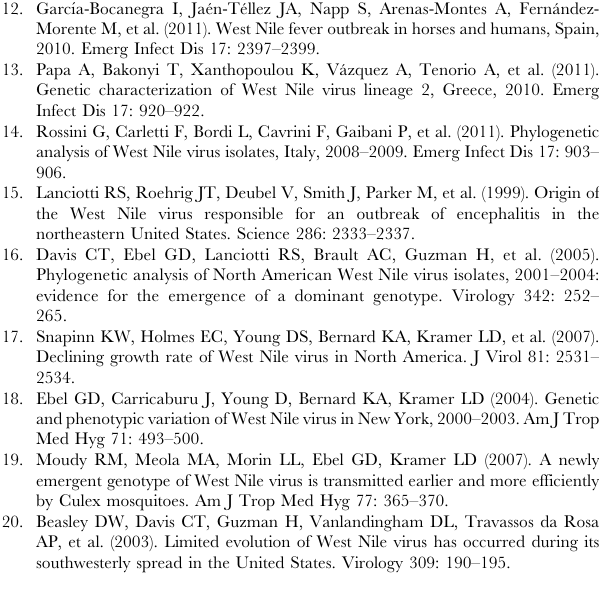
is color-coded according to the insert at the bottom of the figure. Taxon names at the tip of the branches correspond to GenBank accession codes. Figure S2 Consensus maximum-likelihood tree of WNV ORF, from the US (1999–2011), by place of collection (US region) (n =366). Strain IS-98 STD is used as outgroup to root the tree. US regions are color-coded in the branches of the tree as: Northeast (CT, NJ, NY); green, South (FL, GA, LA, MD, MS, TX); orange; Midwest (IL, MI, NE, ND, SD, WI); blue, and West (AZ, CA, CO, ID, NV, UT); red. Strains collected outside the US (Mexico and Israel) are shown in black. Taxon names at the tip of the branches correspond to GenBank accession codes. Figure S3 Consensus maximum-likelihood tree of WNV ORF, from the US (1999–2011), by host (n= 366). Strain IS-98 STD is used as outgroup to root the tree. Host-origin is color-coded in the branches of the tree as: mammals other than humans (black), human (red), avian (blue) and mosquito (green). Taxon names at the tip of the branches correspond to GenBank accession codes. Figure S4 Maximum clade credibility tree derived from the Bayesian analysis of the ORF of WNV strains infecting humans in the US, 1999–2011. WNV genotypes are color-coded in the branches of the tree as NY99 (black), WN02 (blue), SW/WN03 (purple) and cluster MW/WN06 (red). The posterior probability for the nodes in the tree is indicated by a red circle ( P . 0.85). Figure S5 Consensus maximum-likelihood tree of all available WNV ORF from the US, 1999–2011 (n= 363), in annotated version including spatial and temporal distribution of the different US WNV genotypes, and taxon names at the tip of the branches, corresponding to GenBank accession codes. WNV genotypes are color-coded in the branches of the tree as NY99 (black), intermediate (orange), WN02 (blue), SW/WN03 (purple) and cluster MW/WN06 (red). Nodes containing Hu-WNV sequences within genotype WN02 are shown highlighted in green. Amino acid changes defining important nodes are identified with red